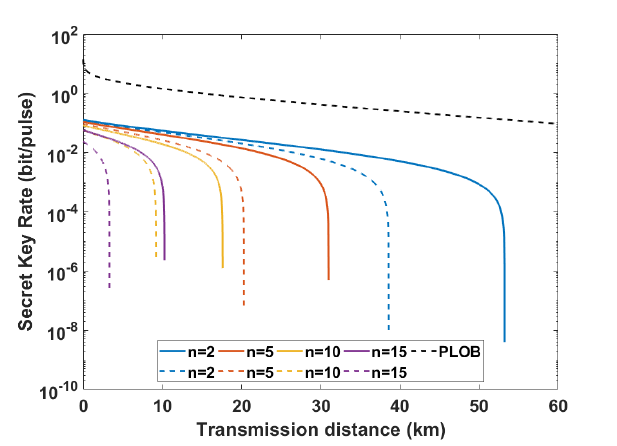
Figure 2. Asymptotic secret key rate of the LLO-based CVQSS. The dashed lines denote the situation of conventional phase noise and the solid lines denote the partially trusted phase noise.